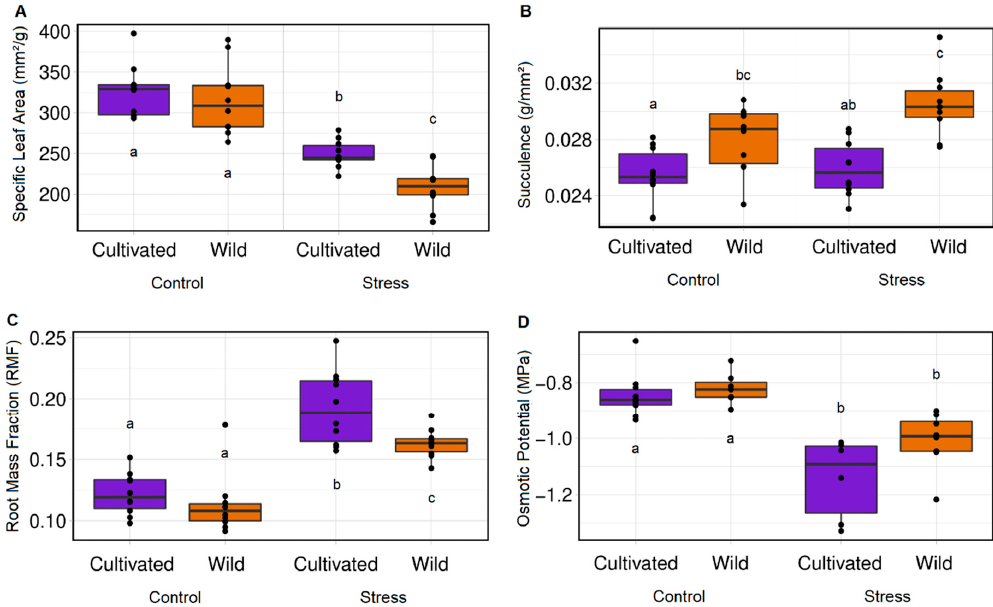
Figure 4. Estimated marginal means of wild and cultivated accessions under the control and stress treatments (grouped by domestication status) for ( A ) Specific leaf area (SLA), ( B ) Leaf succulence on a per area basis of a most recently fully expanded leaf (MRFEL)), ( C ) Root mass fraction (RMF) (calculated by root mass / total biomass) and ( D ) Osmotic potential taken from a rehydrated MRFEL. Different lower-case letters denote significant differences ( p < 0.05) based on post-hoc contrasts from Tukey-HSD tests.